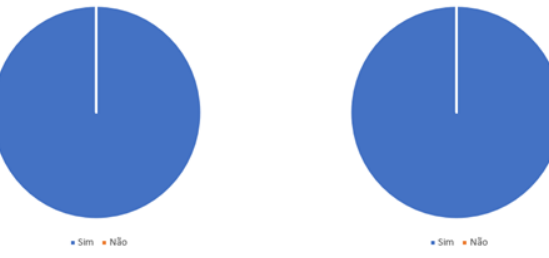
Figure 9. Teachers’ answers to the questions: Do you think your students had fun playing the game? Do you find this game adequate to primary school curriculum?